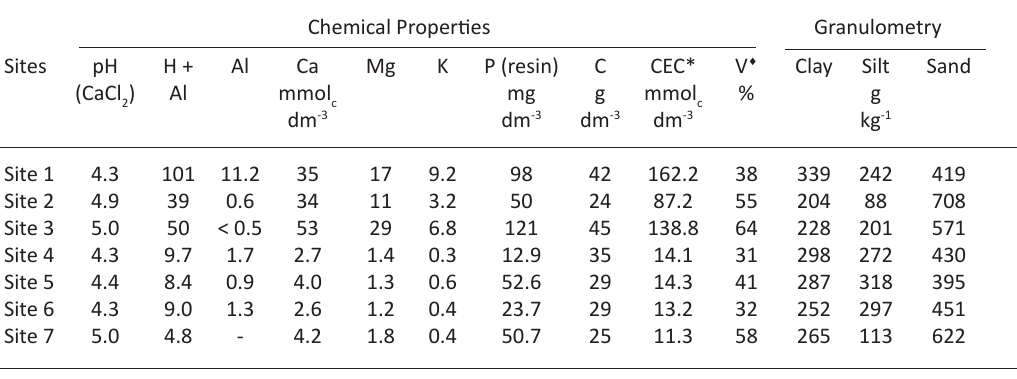
Table 1. Chemical properties and granulometry of the 0-20 cm layer of the soil at the experimental sites Chemical